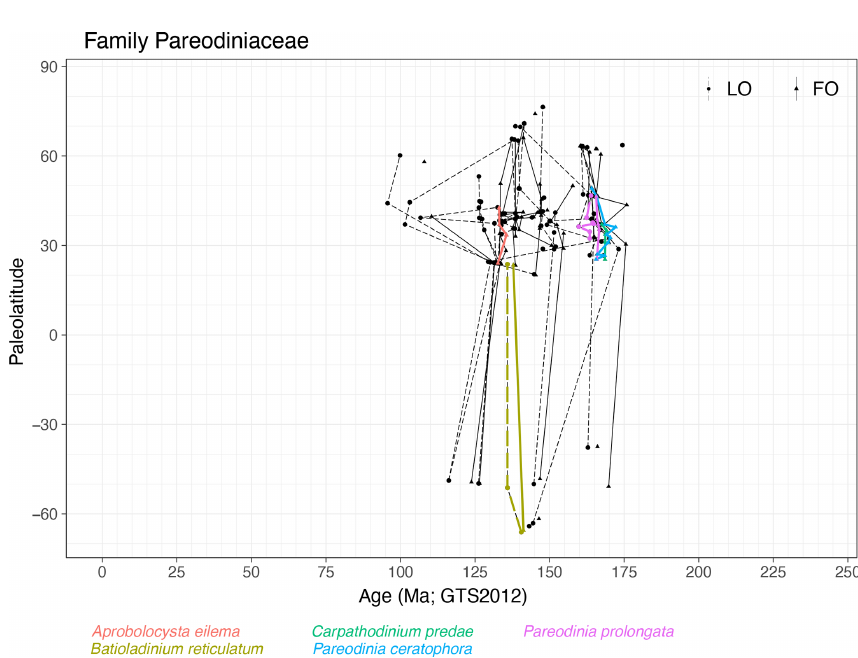
Figure 14. Same as Fig. 5 but for the family Pareodiniaceae.